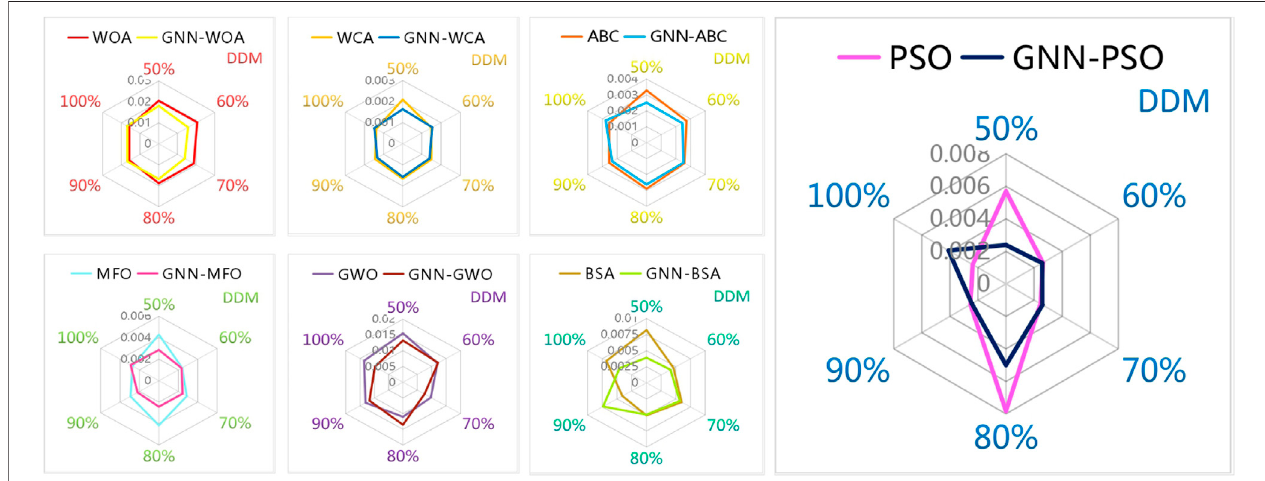
FIGURE 13 | Radar of average RMSE achieved by different algorithms for the